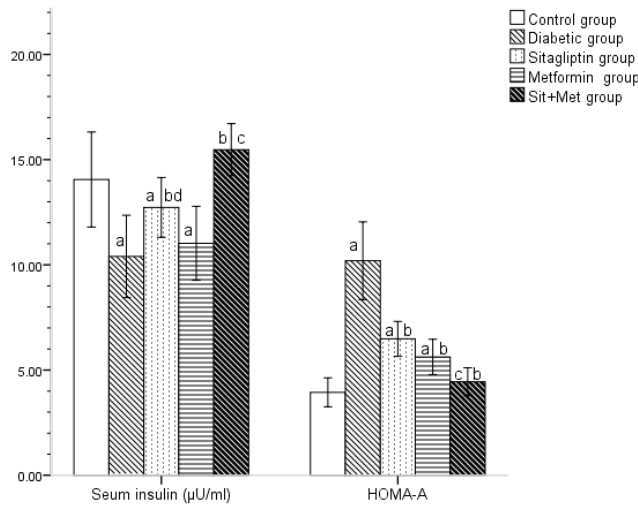
Figure 2. Changes in serum insulin and HOMA-IR in the different studied groups at the end of the treatment period. The values were expressed as mean ± SD (n = 10). a : significantly different, compared to the control group. b : significantly different, compared to the diabetic untreated group. c : significantly different, compared to the sitagliptin and metformin-treated groups. d : significantly different, compared to metformin, using post hoc ANOVA (LSD), P < 0.05.